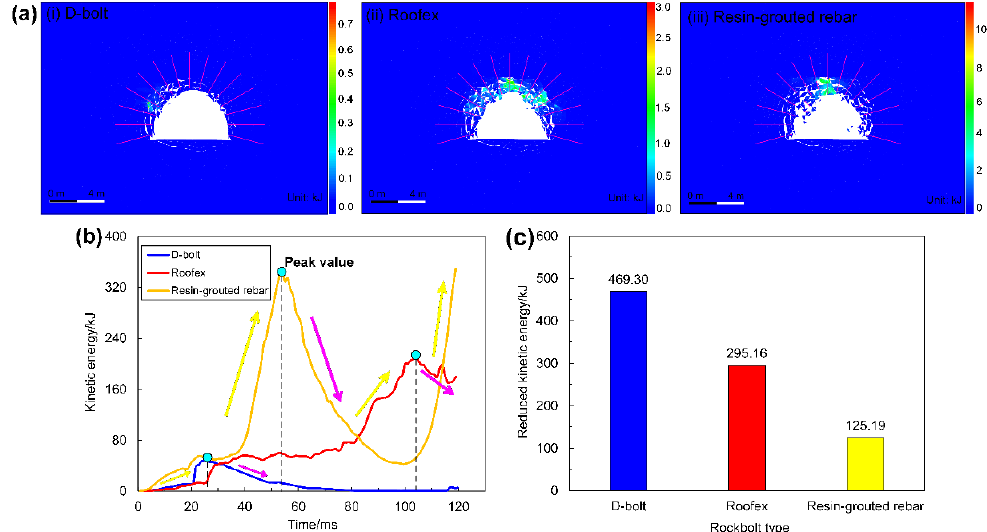
Figure 17. ( a ) Simulated kinetic energy distribution of ejected rock blocks in the tunnel supported by different types of rockbolts. ( b ) is the evolution of kinetic energy of ejected rock blocks. ( c ) is the comparison of reduced kinetic energy of ejected rock